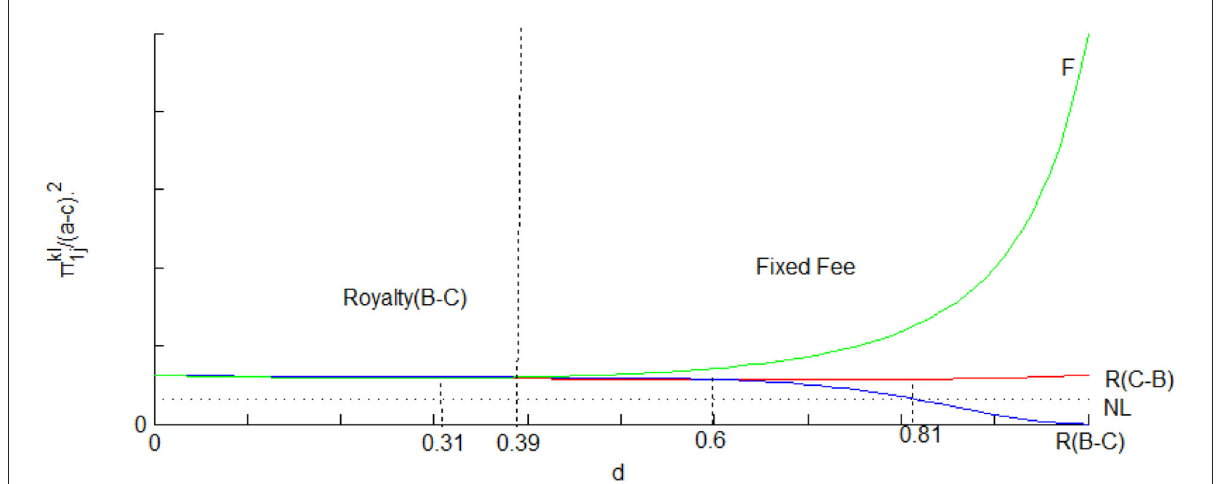
FIGURE1 The profits of Firm 1 in different licensing methods under mixed competition.